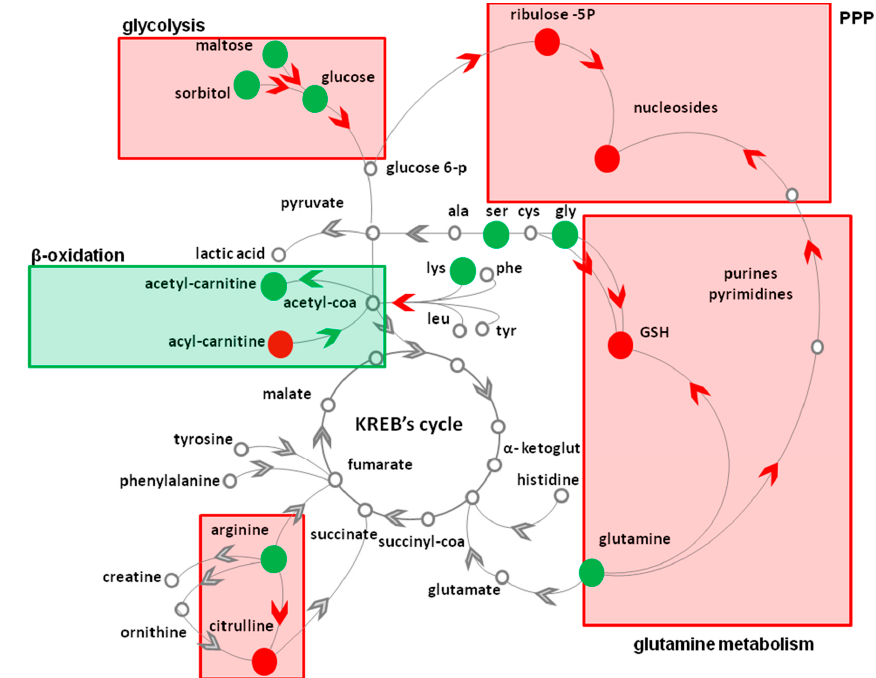
Figure 4. Topical treatment with AAE alters the murine HF metabolome . Schematic cartoon depicting some of the metabolic reactions positively (green box) or negatively (red boxes) affected by AAE in murine HFs. Red and green arrowheads indicate reactions halted or stimulated by AAE, respectively. Red and green dots indicate metabolites whose intracellular concentration resulted decreased or increased by treatment with AAE,